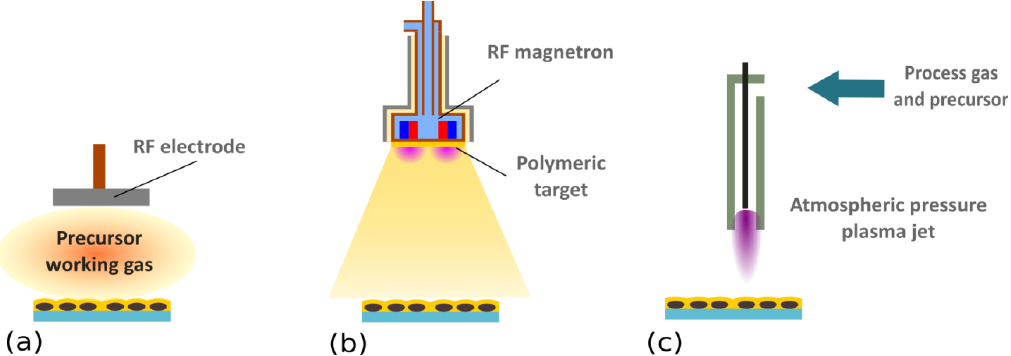
Figure 3. Schematic representation of possible plasma-based strategies for the overcoating of Ag NPs. ( a ) Plasma-enhanced chemical vapor deposition (PE-CVD). In this method, organic vapours or precursors are introduced into the plasma, where they are activated and fragmented. Formed radicals